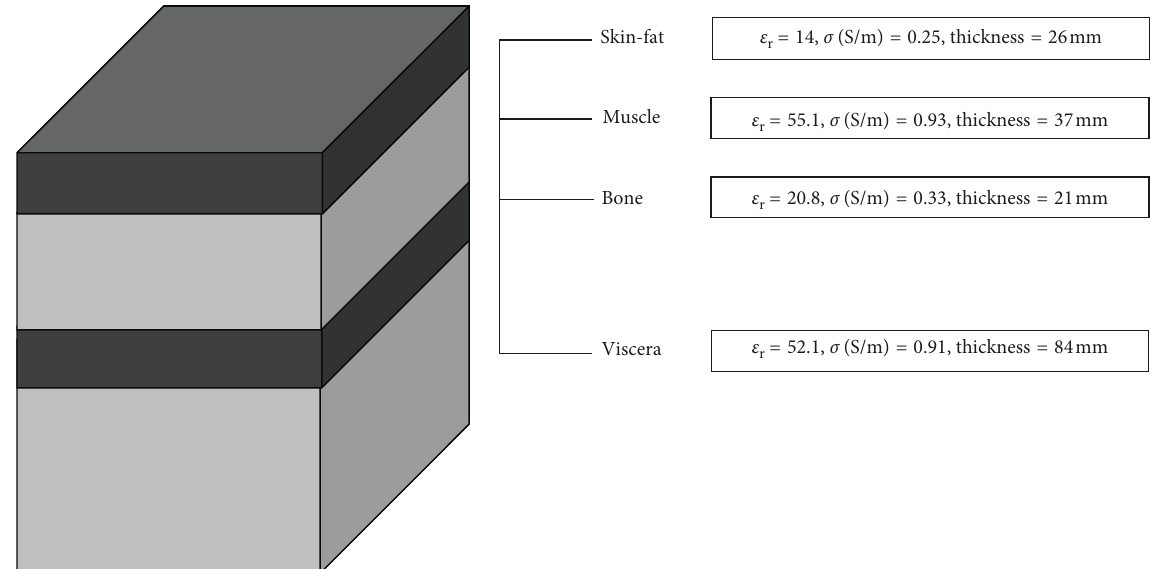
Figure 4: Geometrical and electrical parameters of the layered anatomical phantom of human torso at 870MHz.